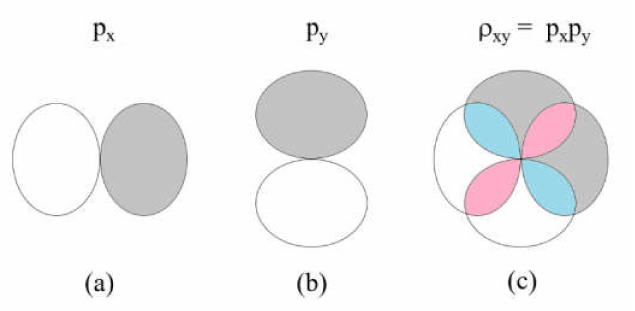
Figure 5. The overlap density resulting from two p-orbital at a given atomic site: ( a ) a p x orbital; ( b ) a p y orbital; and ( c ) the overlap density between the two orbitals, ρ xy = p regions have positive and negative values,